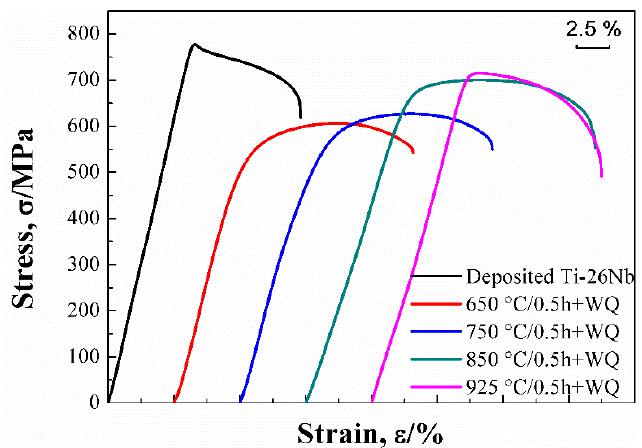
Figure 12. Stress-strain curves of Ti–26Nb alloys after annealing at different temperatures.